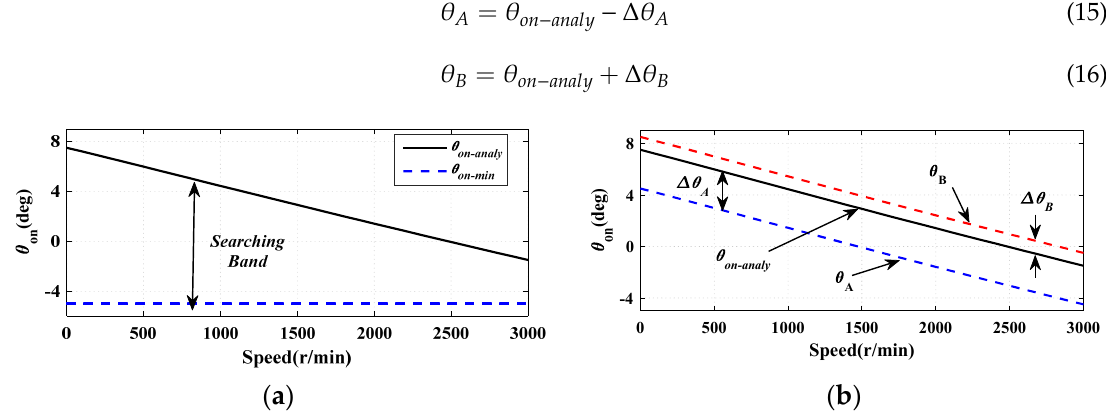
Figure 4. The searching band of angles: ( a ) the searching band; ( b ) the optimum searching band. ∆ θ ∆ θ A and B are correlated with the required level of optimization. In this paper, ◦ and ∆ θ B is set to 1 . These limits will not only achieve the desired optimization level but also ensure a smooth variation of the firing angles with motor speed and current. They also involve the production of the